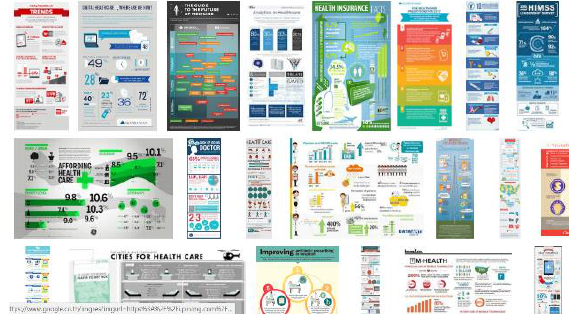
Figure 3 . Infographics about Health Care available online